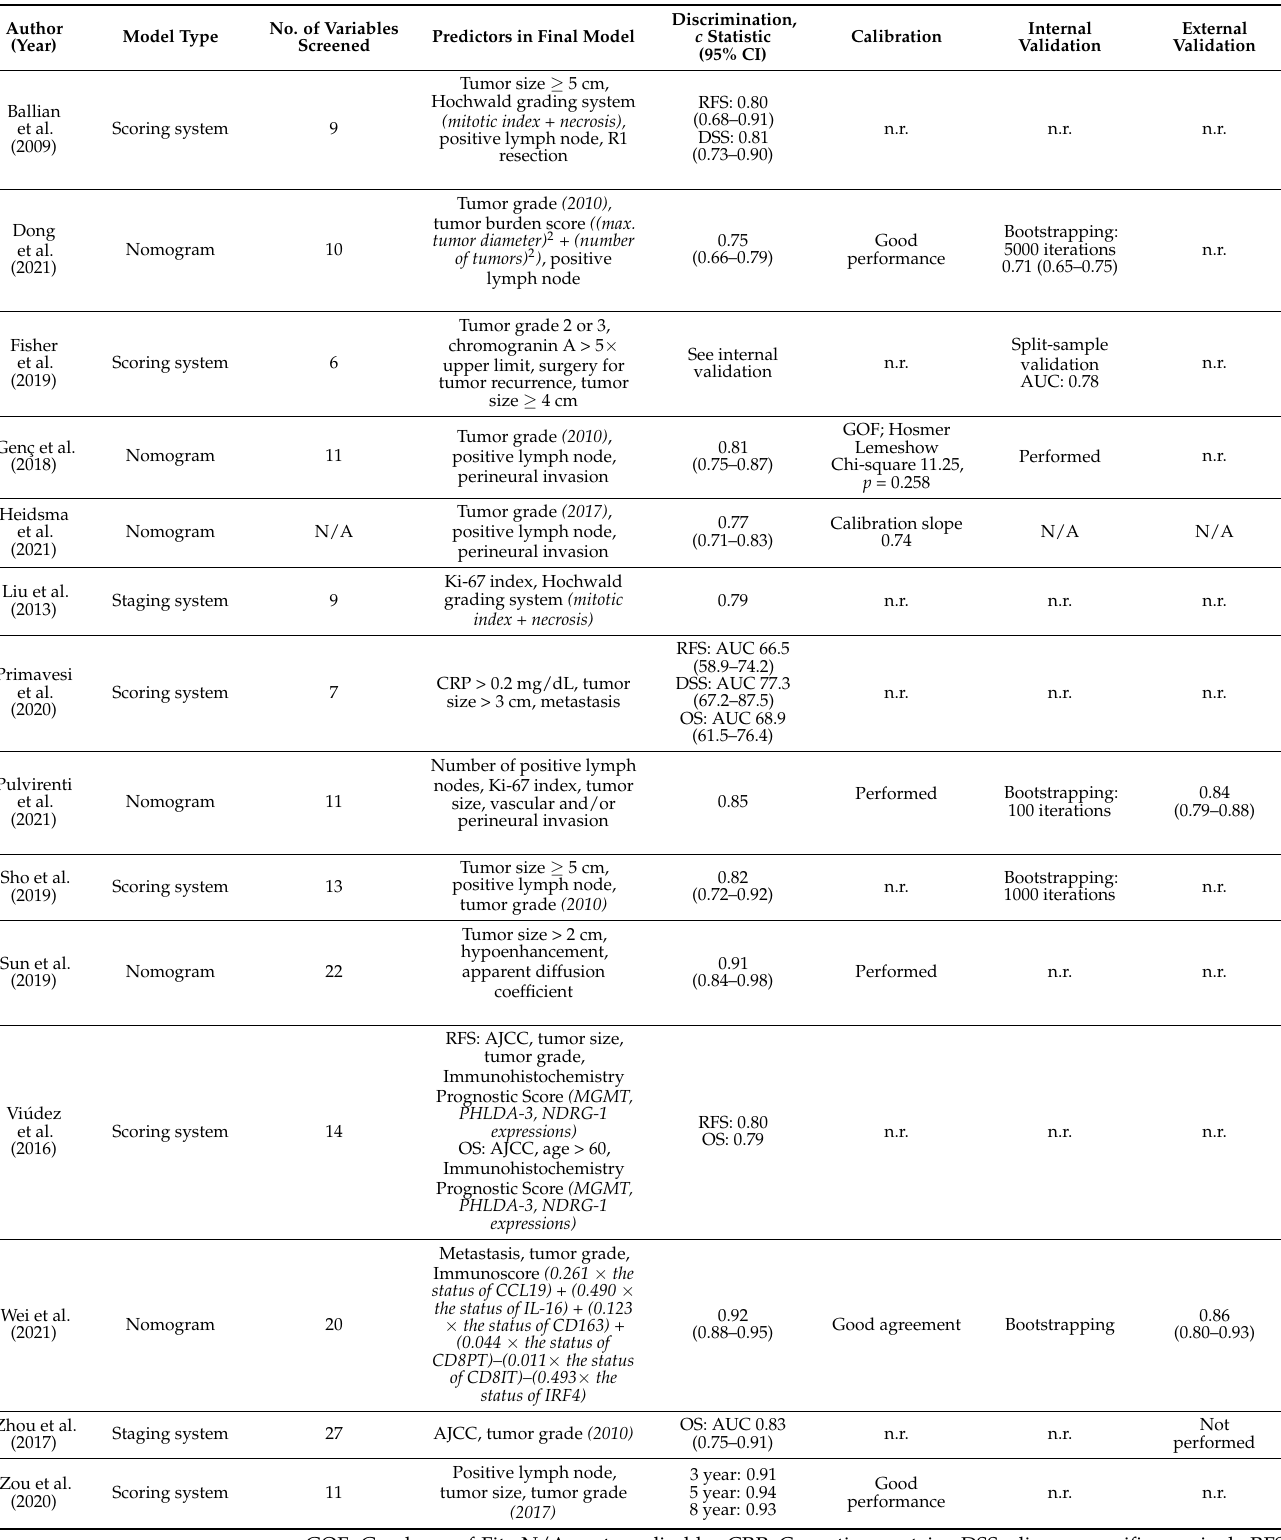
Table 2. Prediction model